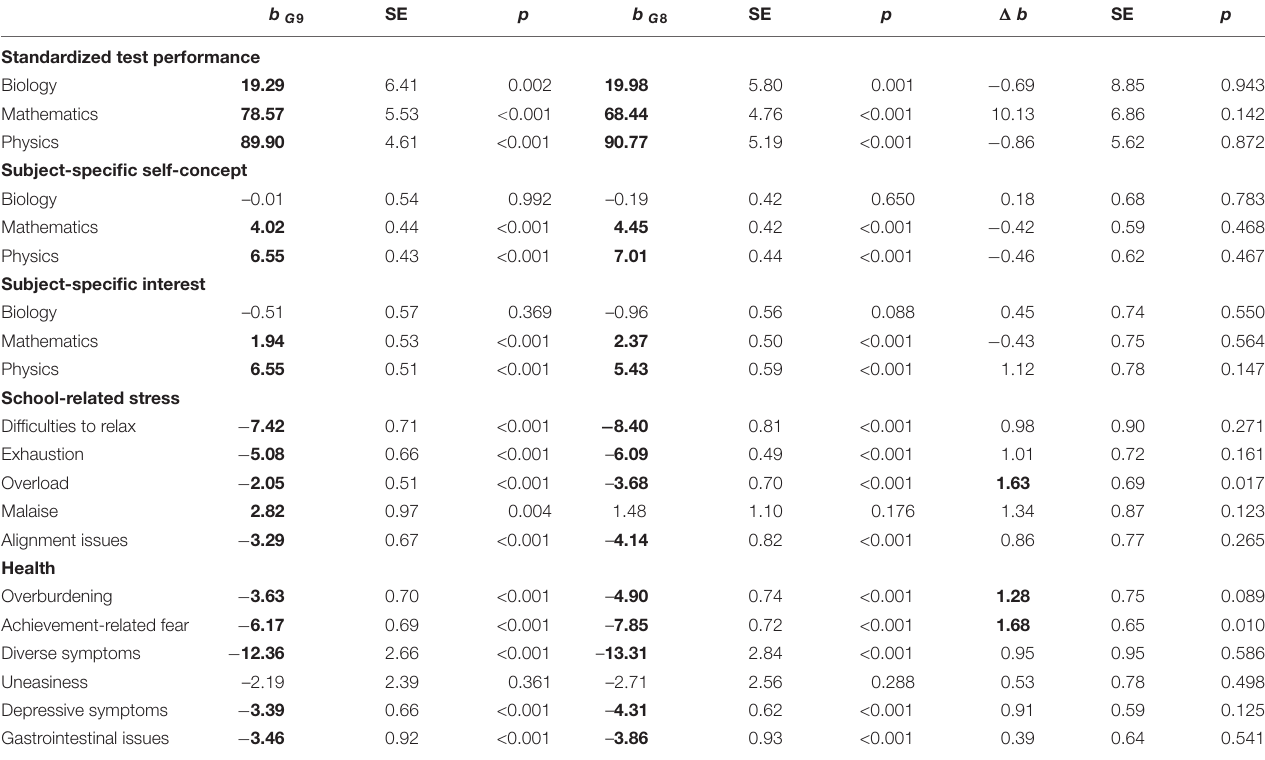
TABLE 3 | Adjusted gender-disparities before and after the reform on standardized test performance, subject-specific self-concept and interest, and school-related stress and